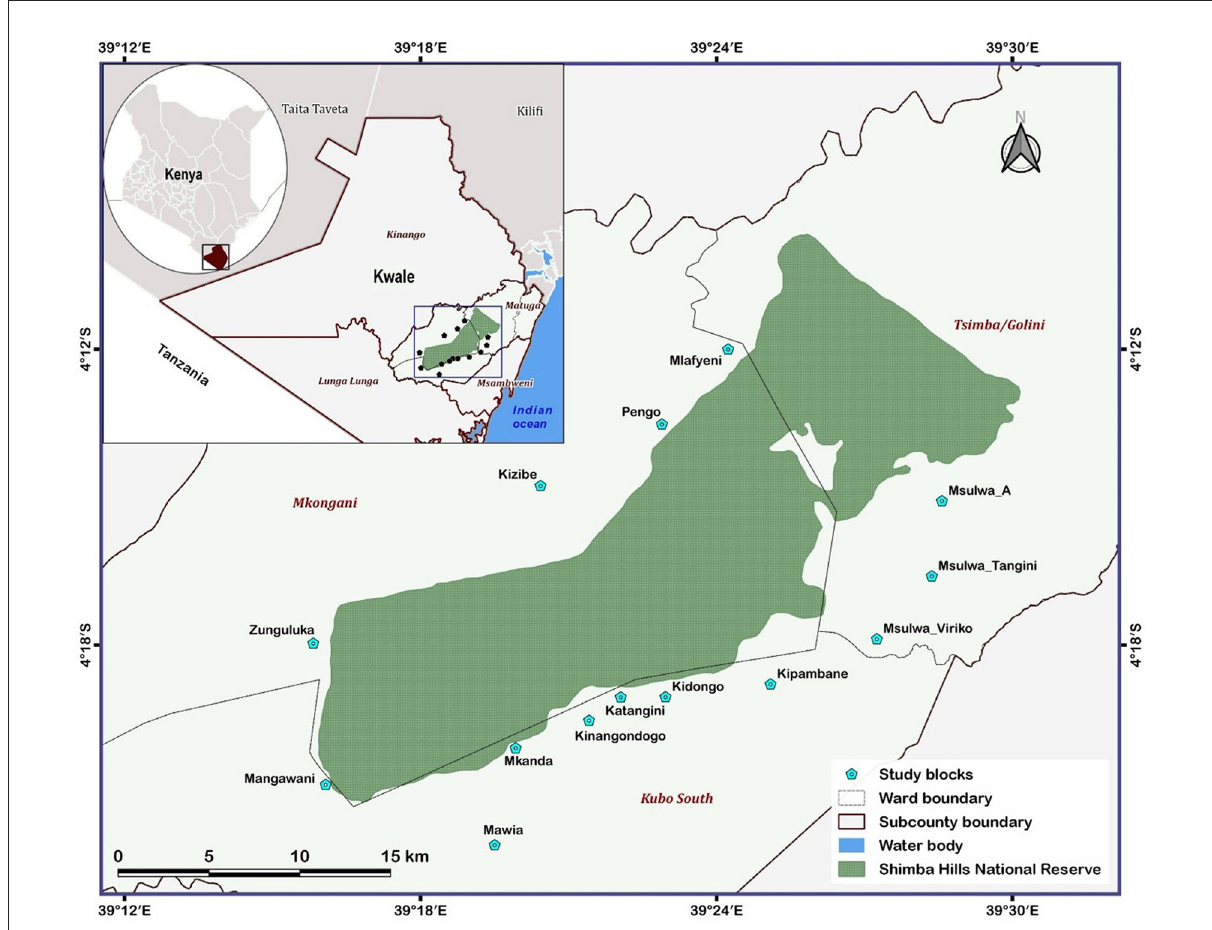
FIGURE1 Map showing the 14 study blocks situated within 5km of the Shimba Hills National Reserve, Kwale county, Kenya.